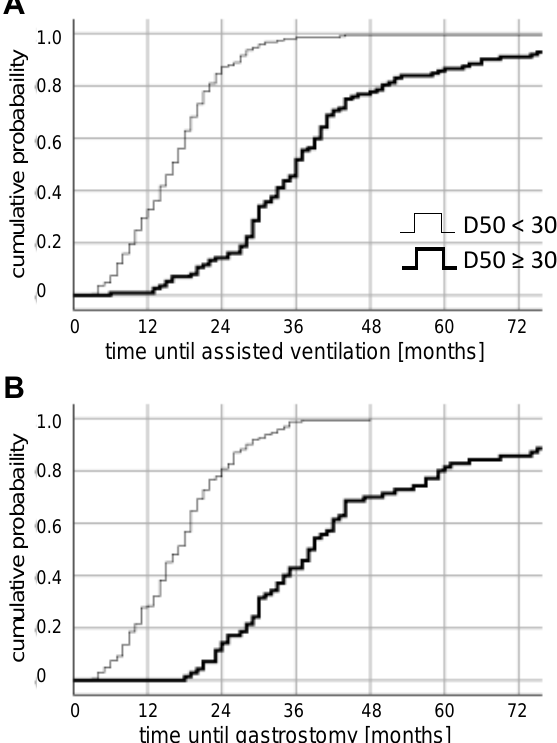
Figure 5. Retrospective stratification of patients via D50 for the cumulative probability of the initiation of therapies after symptom onset. Patients were divided in subgroups of high disease aggressiveness (D50 < 30 months, slim graphs) and low disease aggressiveness (D50 ≥ 30 months, bold graphs). The time is calculated from symptom onset until A ) initiation of assisted ventilation (invasive or non-invasive), B ) implantation of a feeding-tube. Notably, both events occurred significantly earlier in the group with a lower D50 (Log Rank p < 0.001).